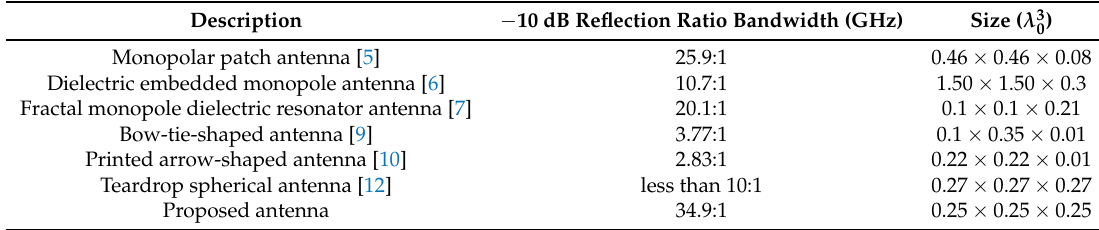
Table 1. Comparison of the proposed antenna and 3D antennas in previous studies (note that λ 0 is the wavelength corresponding to the lowest operating